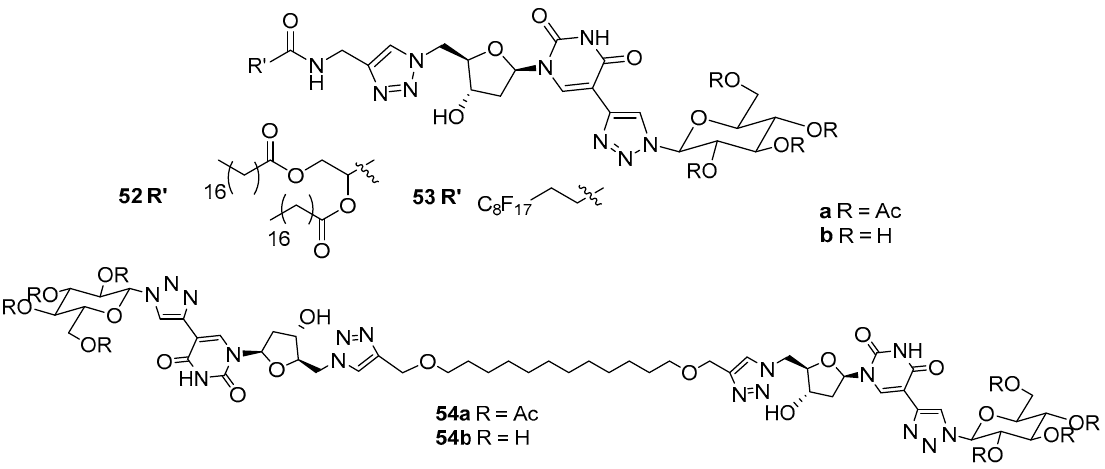
Figure 37. Uracile based glycosyl-nucleoside-lipids amphiphiles and bolaamphiphiles [83].